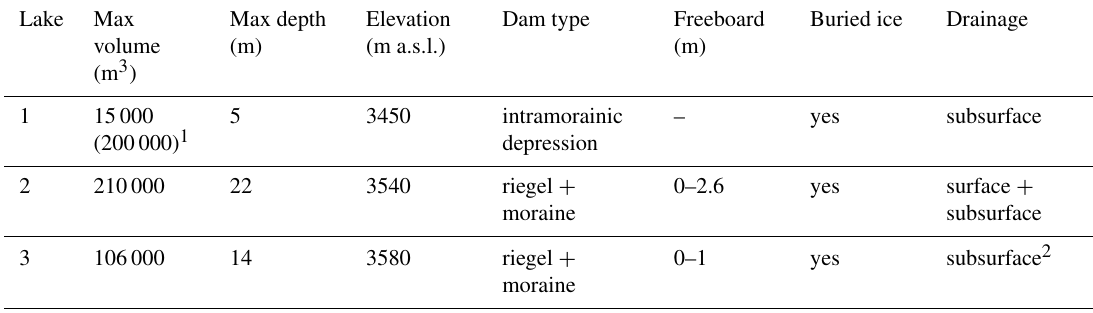
Figure 1. Overview of the Adygine ice-debris complex (a) and its recent dynamics; exposure of buried ice embedded within perennially frozen ground (b, c) . 1–7 are the studied lakes; P1–P3 refer to geophysical profiles. Study site marked with an arrow on map of Kyrgyzstan (upper left corner). Positions of (b) and (c) are marked on Fig. 1a. Image source: Worldview-2 (2011); photo: K. Falatkova (2017). Table 2. Basic parameters of the three largest lakes of the